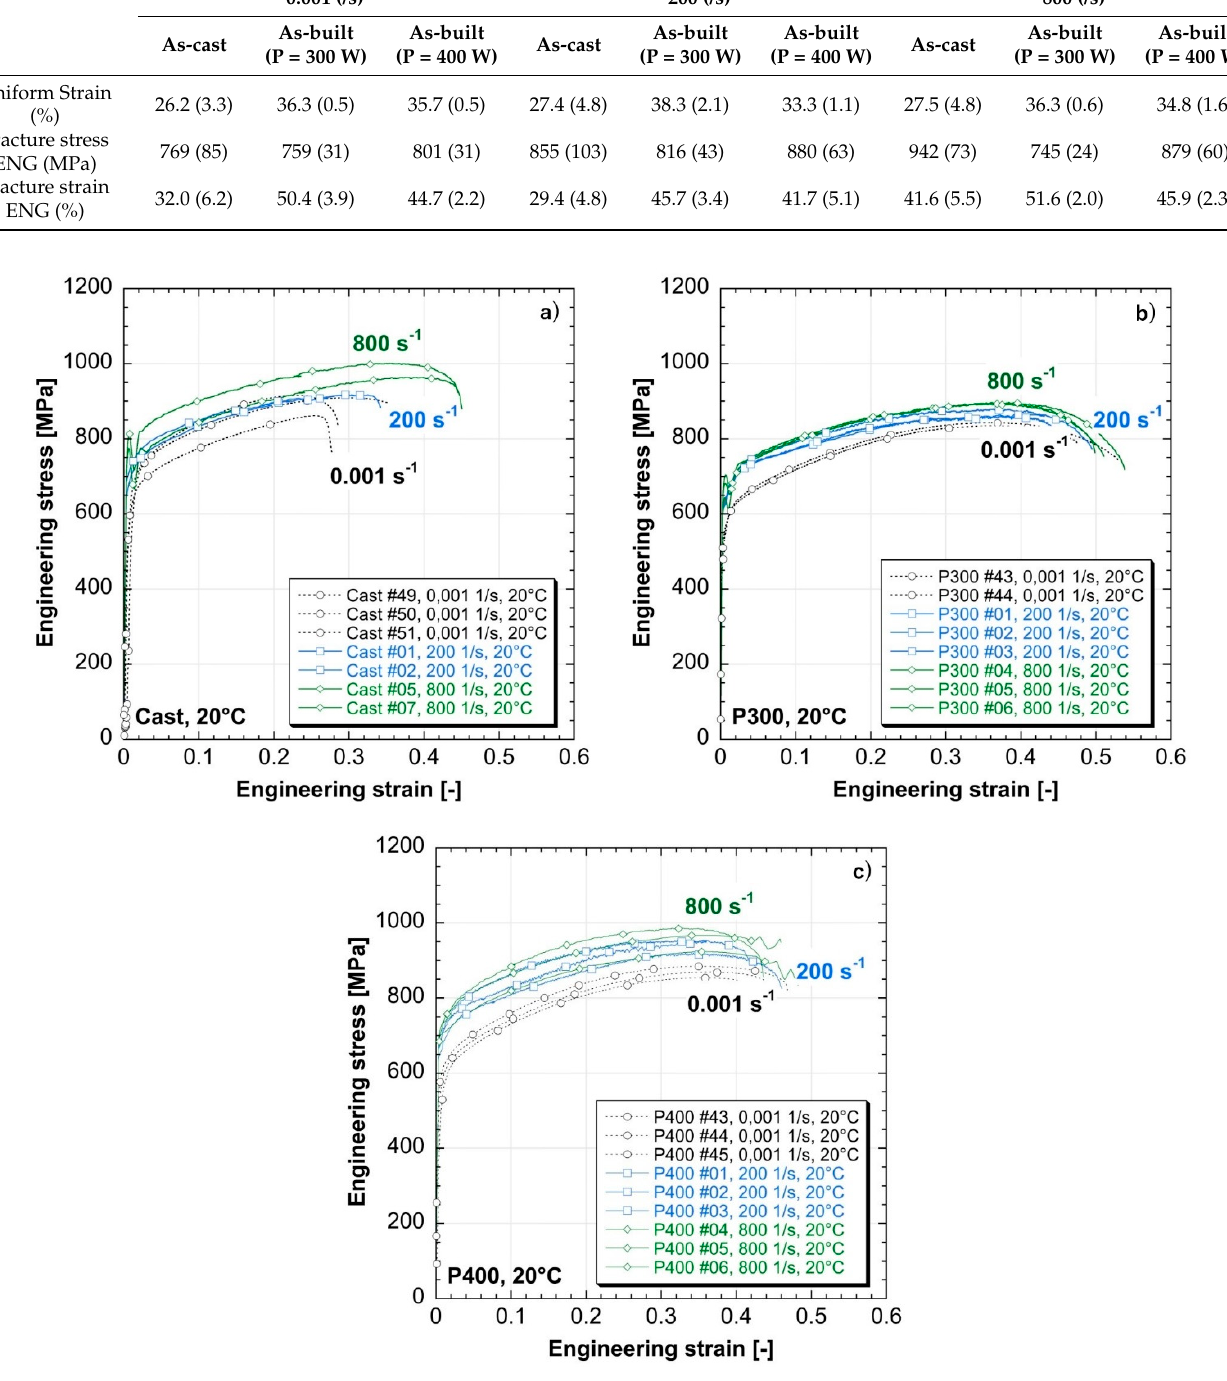
Figure 12. Mechanical behavior of the realized specimens at different strain rates: ( a ) as-cast; ( b ) as-built at 300 W; ( c ) as-built at 400 W.